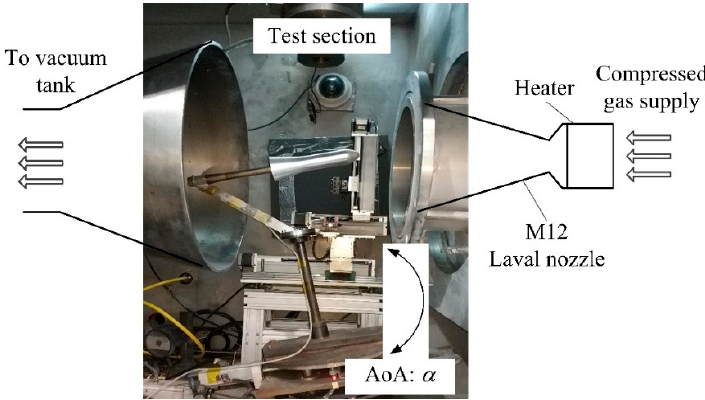
Figure 8. Schematic of the hypersonic wind tunnel set-up.